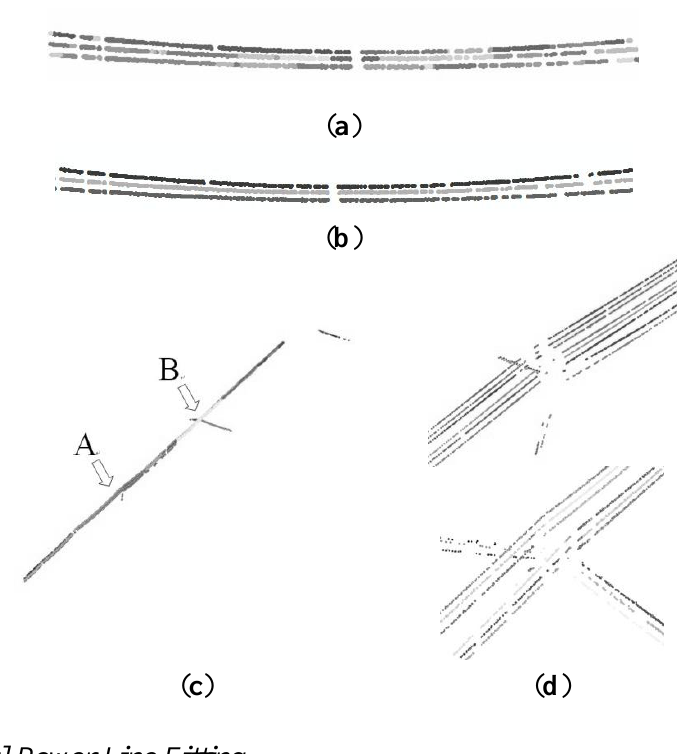
Figure 10. Power line points clustering. ( a ) Clustering results using AutoClust. ( b ) Growing the local fitted lines. ( c ) Clustering results for the overall dataset. ( d ) Magnified sections of clustered result at points A and B.